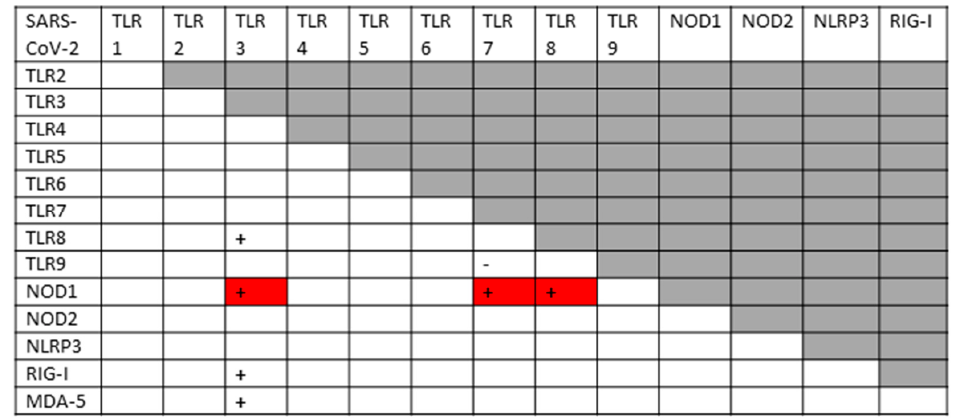
Figure 4. Predicted synergisms (+) and antagonisms ( − ) resulting from SARS-CoV-2 activation of innate receptors resulting from mapping Figure 3 (literature review of innate receptor activation) onto the template provided by Figure 2 (summary of known innate receptor synergisms and antagonisms). Red entries indicate extracellular (“bacterial antigen”) receptor synergisms with intracellular and endosomal (“viral antigen”) receptors.